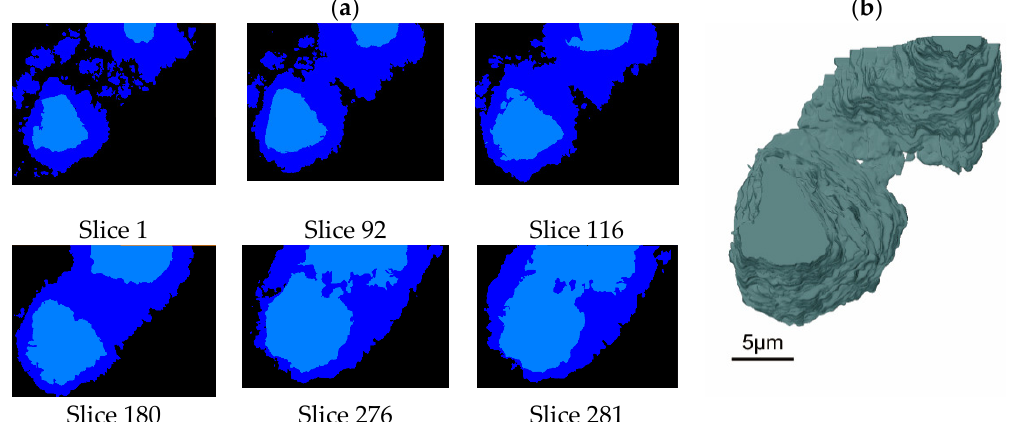
Figure 3. Labeled images and 3D image of hydrated C 3 S: ( a ) labeled images of numbered slices and ( b ) 3D image of an anhydrous particle.